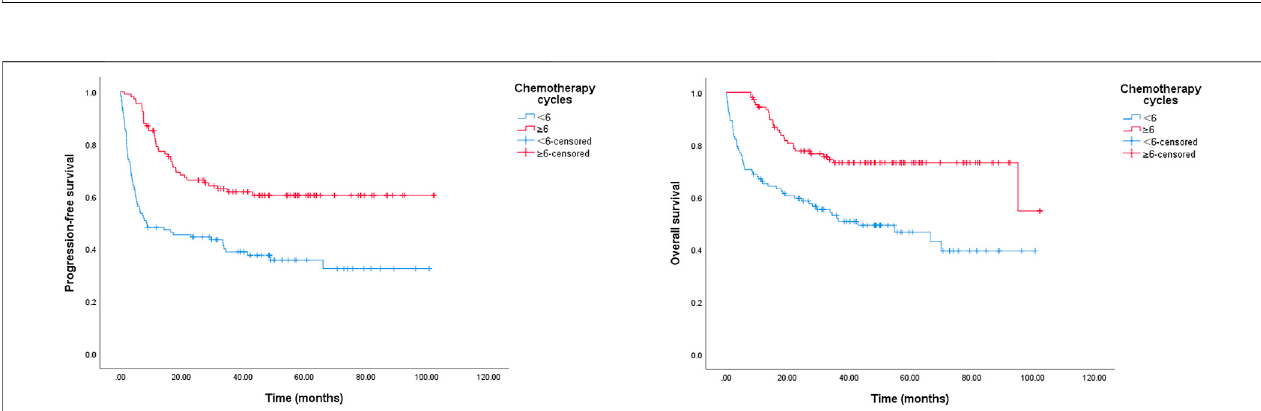
FIGURE 3 | Kaplan-Meier survival curve of PFS and OS for DLBCL patients strati fi ed by reduction in chemotherapy dose. The 2-year PFS rates were 62.4% (chemotherapydosereductiongroup)and59.4%(standarddosegroup),respectively, p =0.567;the2-yearOSrateswere67.3%(chemotherapydosereductiongroup) and 73.7% (standard dose group), respectively, p = 0.139.